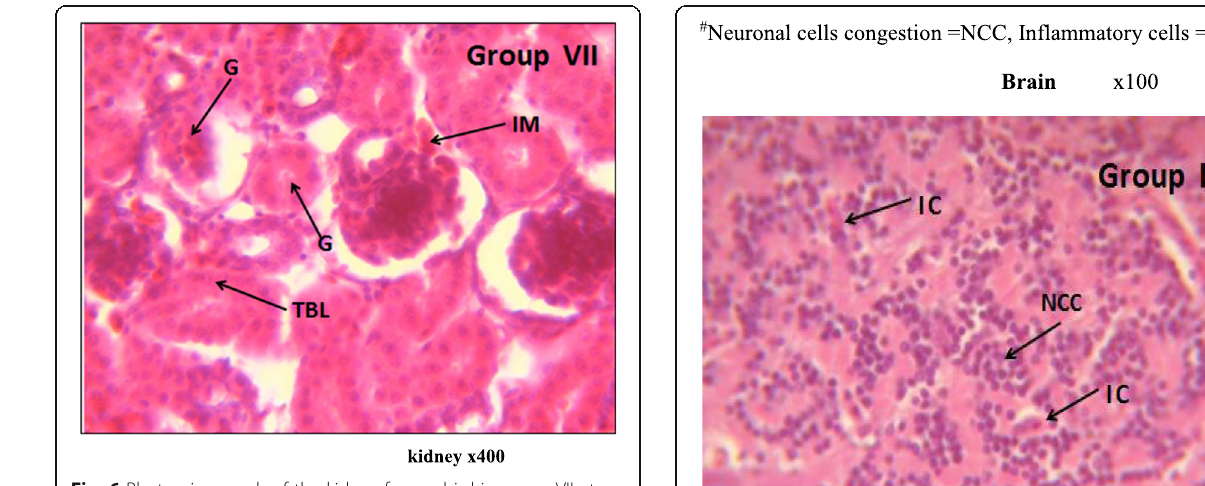
Fig. 6 Photomicrograph of the kidney from a bird in group VII at the end of 12 weeks of direct exposure to 3 mg CN kg − 1 body weight. G, glomera; TBL, tubular brush-border loss; IM, mild